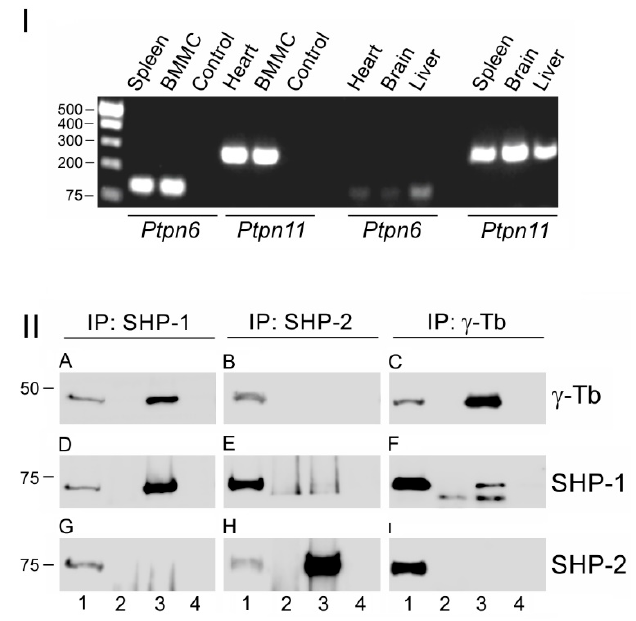
Figure 2. The SHP-1 and SHP-2 in complexes containing γ -tubulin. ( I ) The expression profile of SHP-1 and SHP-2 in selected mouse tissues and BMMCs: A gel-based RT-PCR analysis of mouse SHP-1 ( Ptpn6 ) and SHP-2 ( Ptpn11 ) is shown. Mouse spleen and heart served as positive controls for SHP-1 and SHP-2, respectively. ( II ) The extracts from BMMCs precipitated with immobilized Abs specific to SHP-1 ( A , D , G ), SHP-2 ( B , E , H ), or γ -tubulin sequence 434–449 ( C , F , I ): The blots were probed with Abs to γ -tubulin ( γ -Tb), SHP-1, and SHP-2. The load ( lane 1 ), the immobilized Abs not incubated with cell extracts ( lane 2 ), the precipitated proteins ( lane 3 ), and the carriers without Abs and incubated with cell extracts ( lane 4 ).